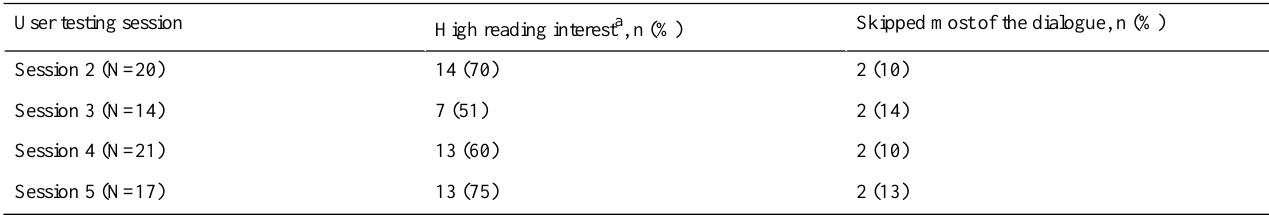
Table 4. Summary of observational data for sessions 2 to